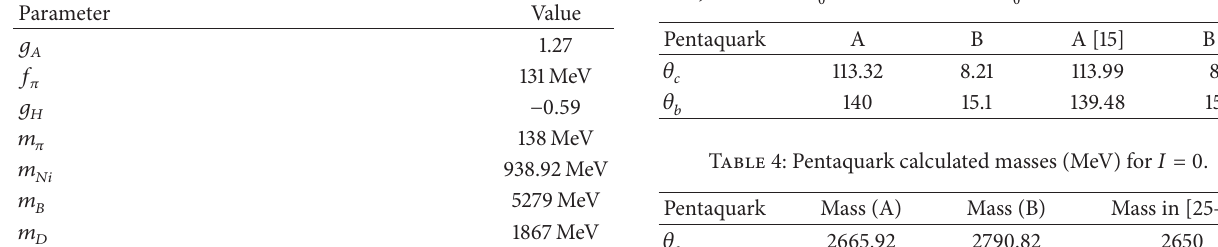
Table 3: The calculated binding energies (MeV) for 𝜃 𝑐 ( 𝐷 meson)